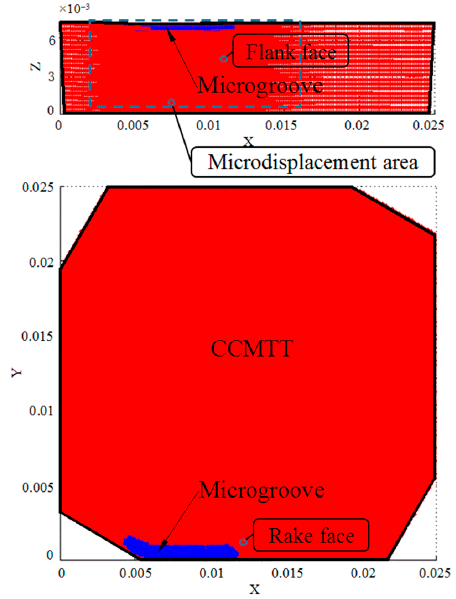
Figure 10. PD analysis results after 3500 iterations of the CCMTT.